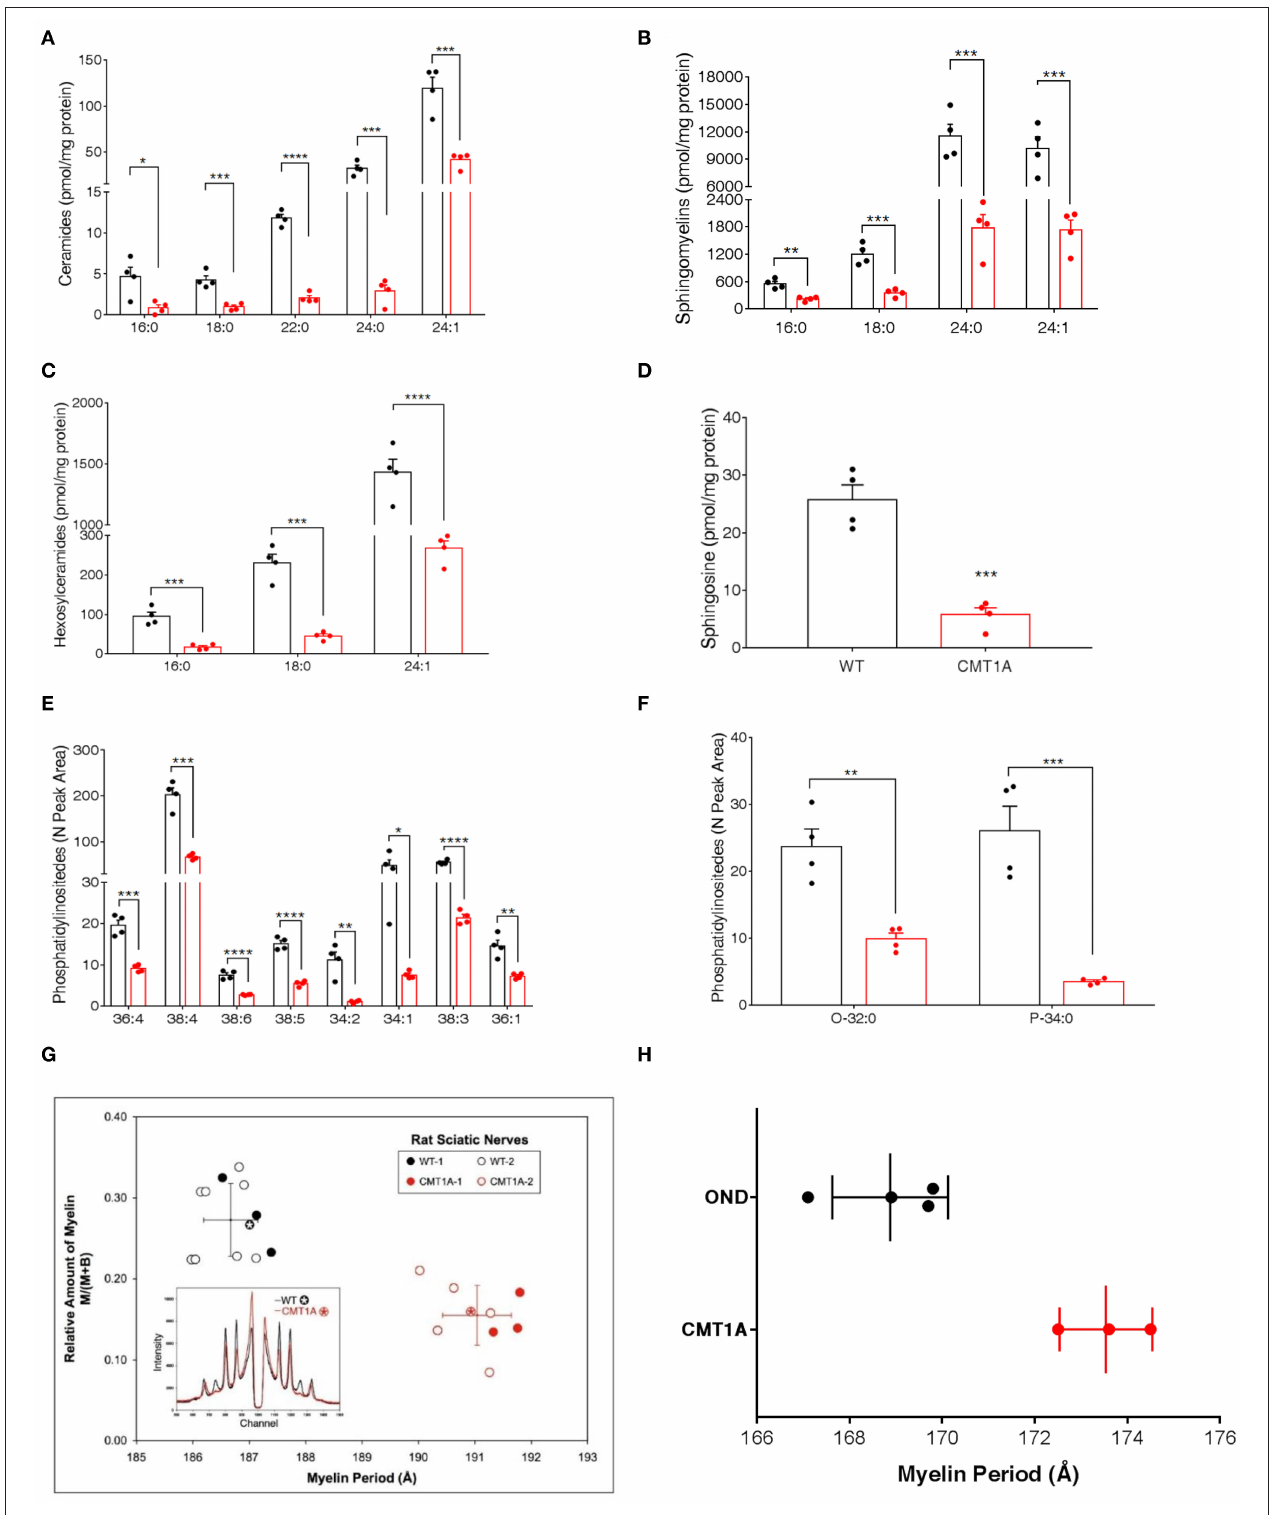
FIGURE 2 | CMT1A myelin displayed perturbed sphingolipid (SP) and glycerophospholipid composition and ultrastructural abnormalities. The most abundant SP species were analyzed by an optimized protocol of targeted mass spectrometry. This method uses 25 standards to calculate the absolute concentration (nM)